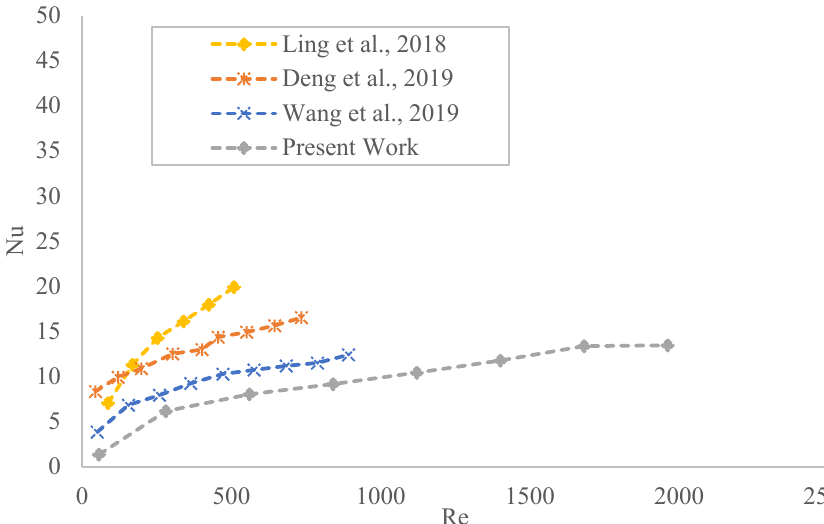
Figure 4. Consistency check for the proposed model.